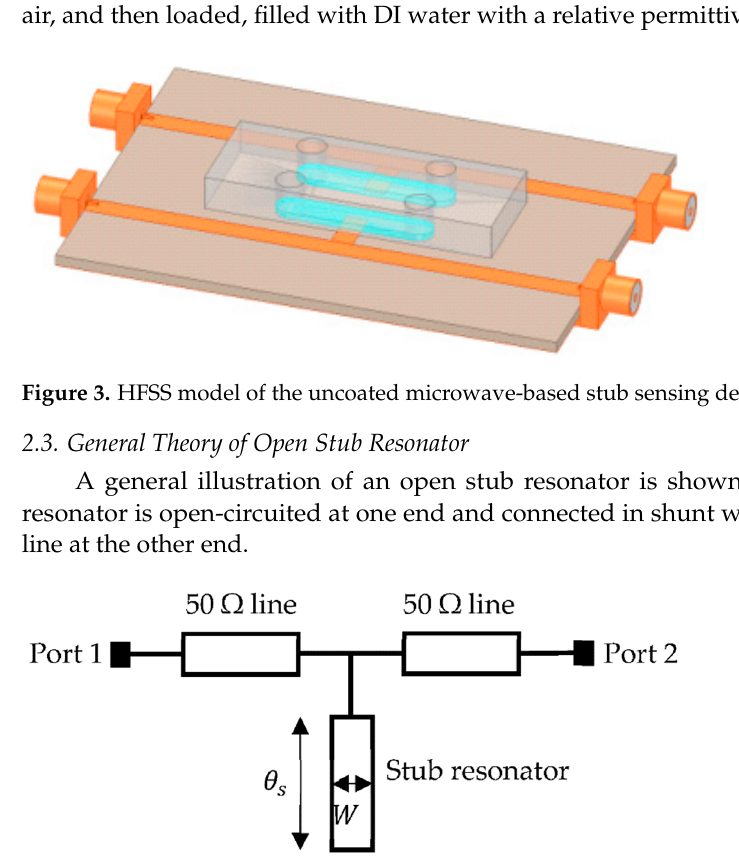
Figure 4. Open stub resonator illustration.